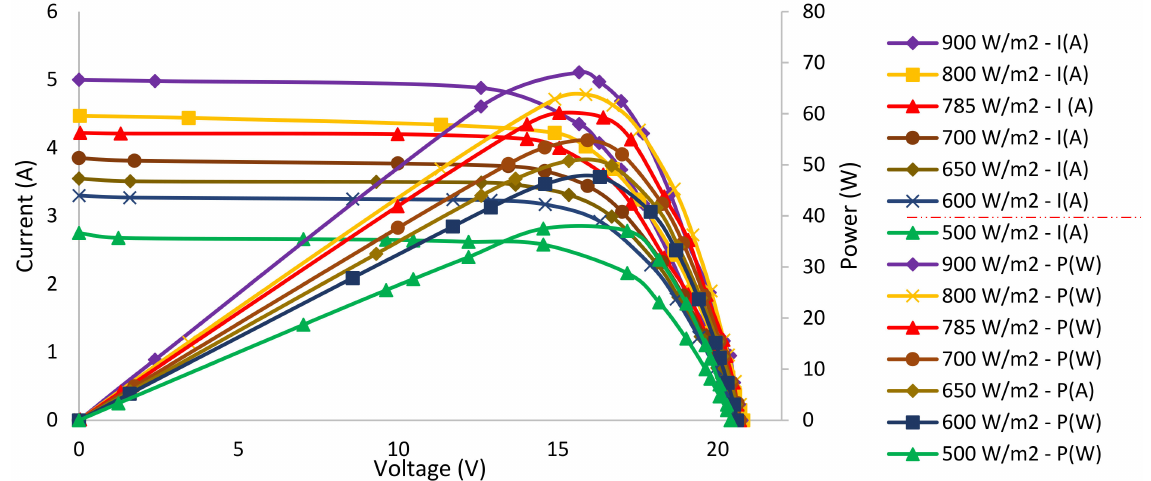
Figure 4. PV panel P1’s characteristics curves (I-V and P-V).3. PV panels characterization at laboratory and ambient